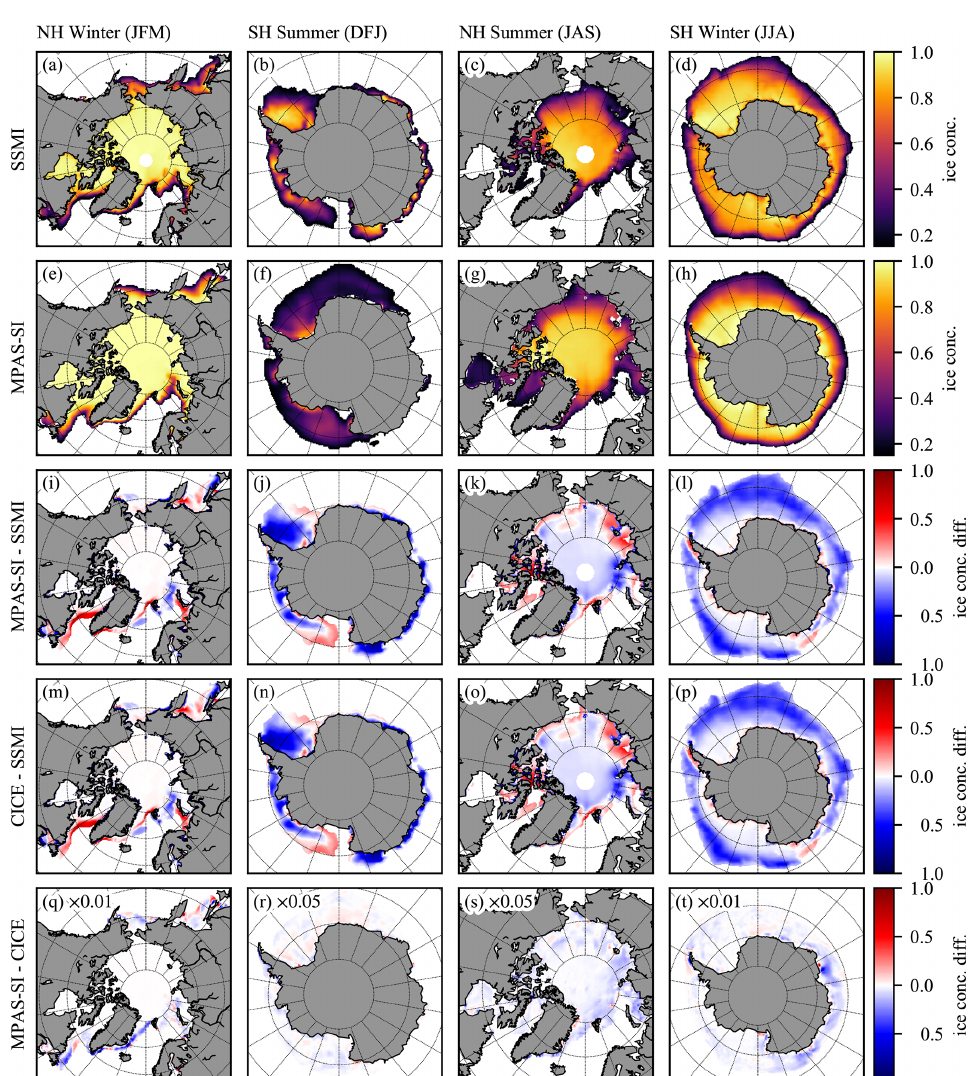
Figure 19. Spatial climatological maps for 1988 to 2007 of sea-ice concentration from (a–d) SSMI satellite observations processed with the NASATeam algorithm and (e–h) MPAS-Seaice. Differences between (i–l) MPAS-Seaice and (m–p) CICE ice concentration and SSMI observations. (q–t) Differences between MPAS-Seaice and CICE ice concentration. (a, e, i, m, q) Northern Hemisphere winter: January, February, and March. (b, f, j, n, r) Southern Hemisphere summer: December, January, and February. (c, g, k, o, s) Northern Hemisphere summer: July, August, and September. (d, h, l, p, t) Southern Hemisphere winter: June, July, and